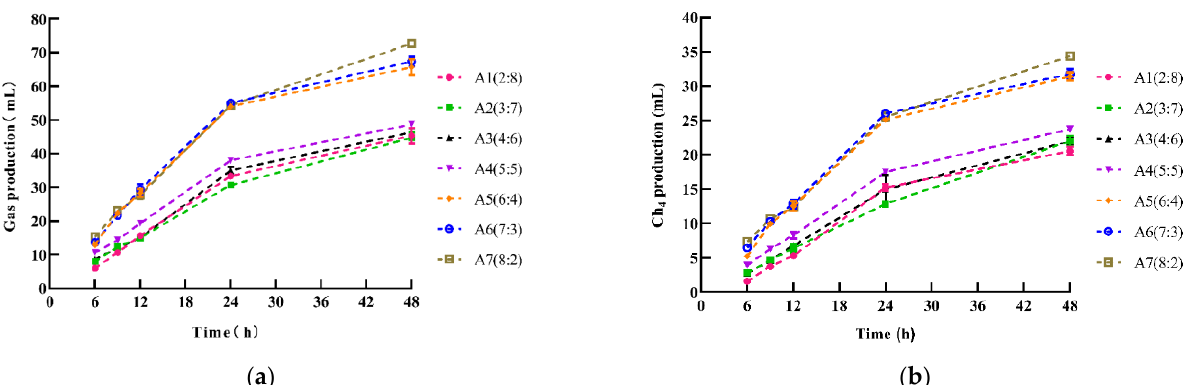
Figure 1. ( a ) In vitro gas production at different time points. ( b ) In vitro CH 4 production at different time points. A1 (2:8), A2 (3:7), A3 (4:6), A4 (5:5), A5 (6:4), A6 (7:3), and A7 (8:2) represent proportions of sorghum straw and ammoniated wheat straw of 2:8, 3:7, 4:6, 5:5, 6:4, 7:3 and 8:2, respectively. The amount of CH 4 in vitro increased significantly with the accumulation of time. At any time, CH 4 contents of A7, A6 and A5 were significantly higher than those of A1, A2, A3, and A4 ( p < 0.05). At 6 h and 48 h, the CH 4 content of A7 was significantly higher than